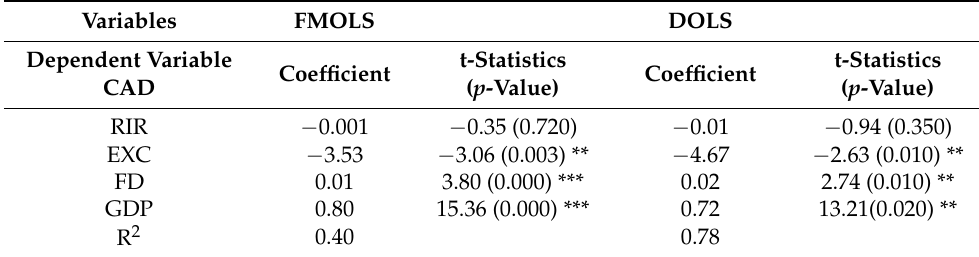
Table 15. Findings of FMOLS and DOLS for